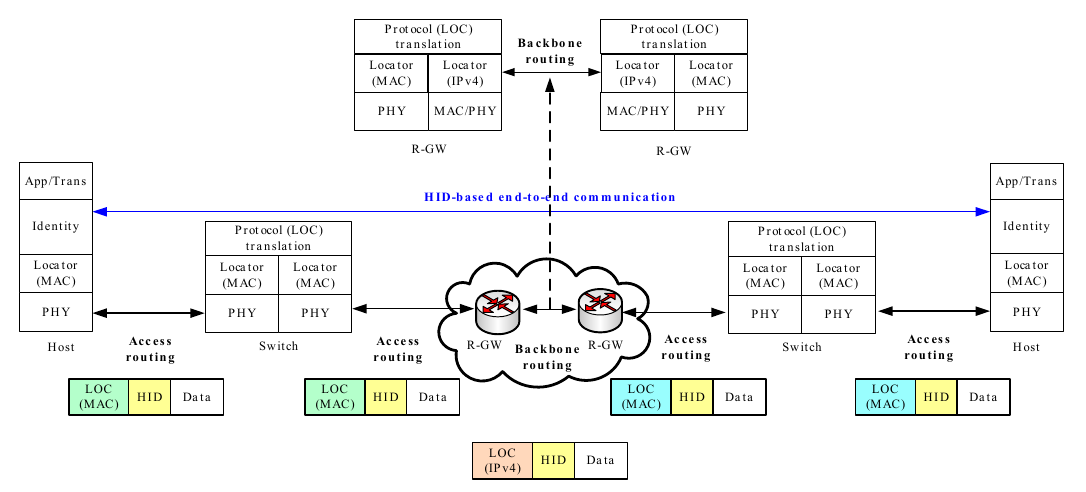
Figure 1. Protocol model for data delivery.